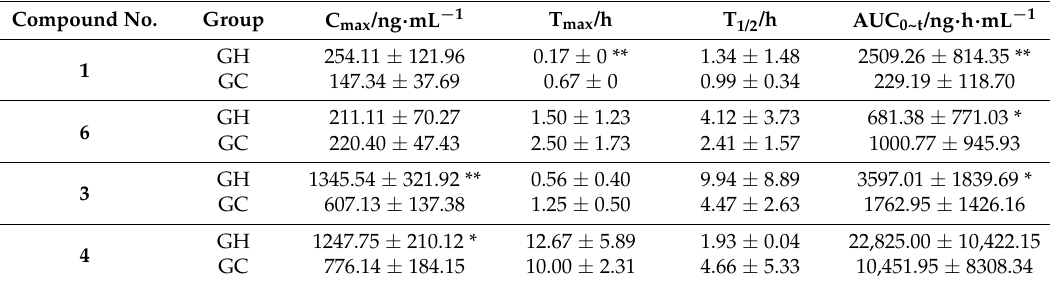
Table 7. Comparison of the Pharmacokinetic Profile of Group GC and GH.